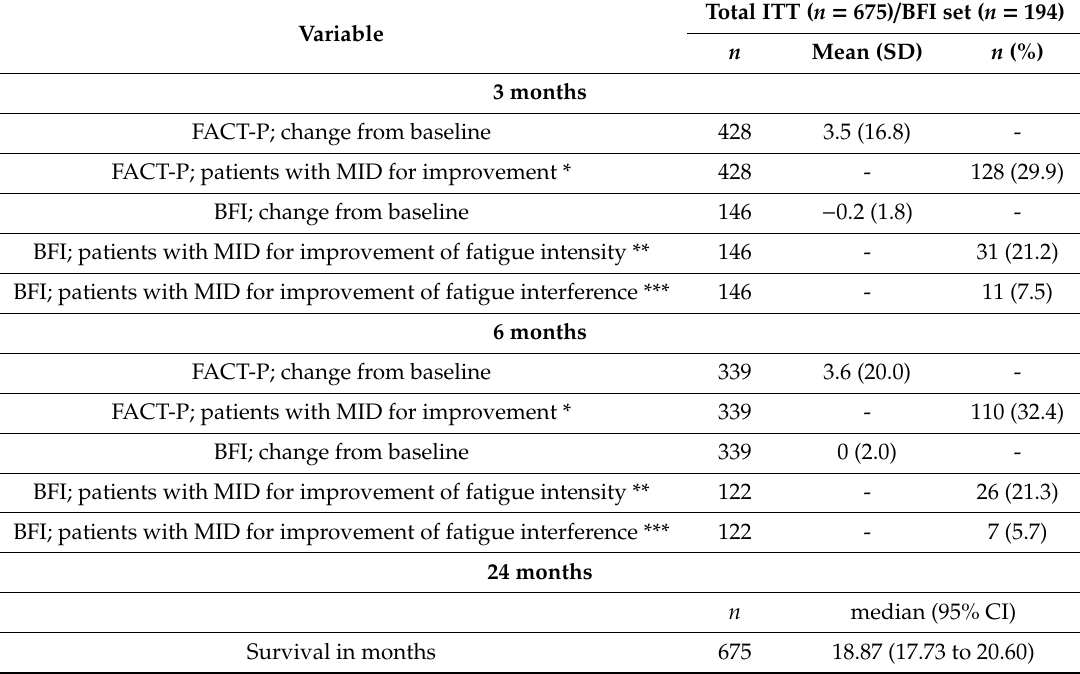
Table 4. Health-related quality of life, fatigue. and